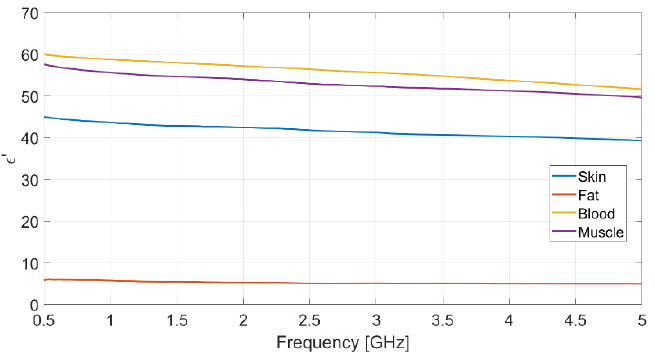
Figure 2. Measured real part of the relative permittivity vs. frequency for each realized bio-phantom.